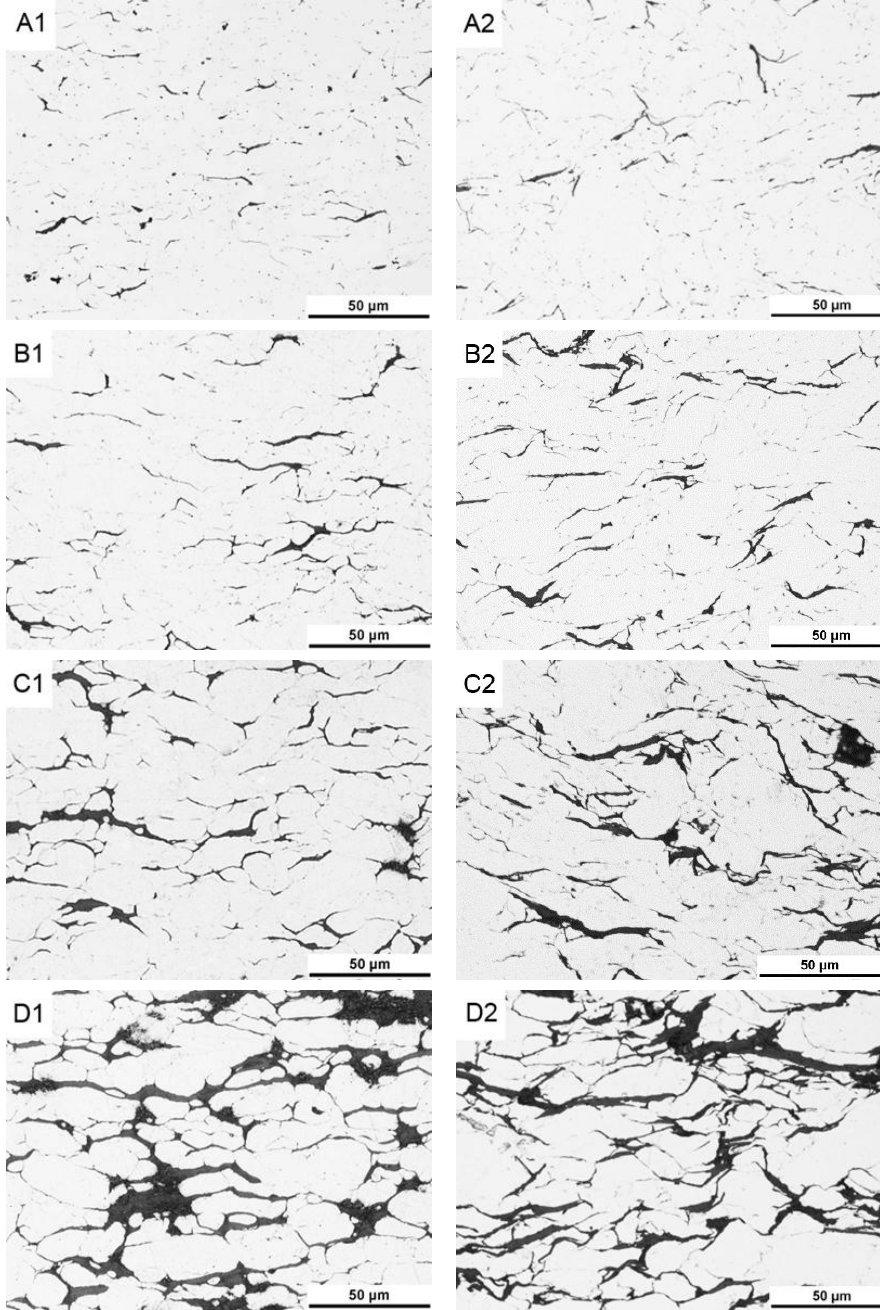
Figure 5. Microstructure of AA6061/MLG composites obtain in SPS ( A1 —2 vol %; B1 —5 vol %; C1 —10 vol %; D1 —15 vol %) and SPT ( A2 —2 vol %; B2 —5 vol %; C2 —10 vol %; D2 —15 vol %)